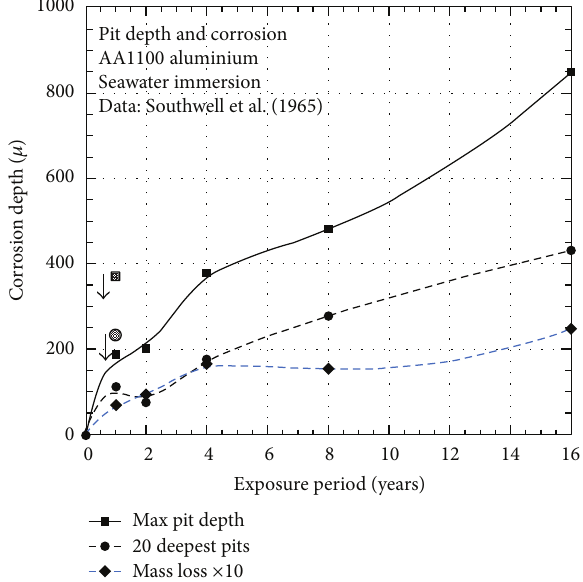
Figure 8: Data and fitted trends for AA1100 exposed to marine immersion conditions. The changeover to mode 2 occurs at about 3 years of exposure. Data from Southwell et al. [2].